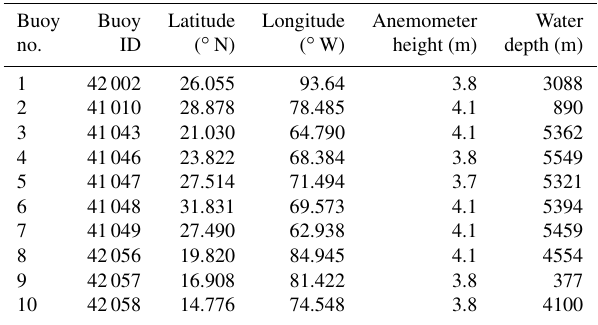
Table 1. List of National Data Buoy Center buoys and their statis- tics.